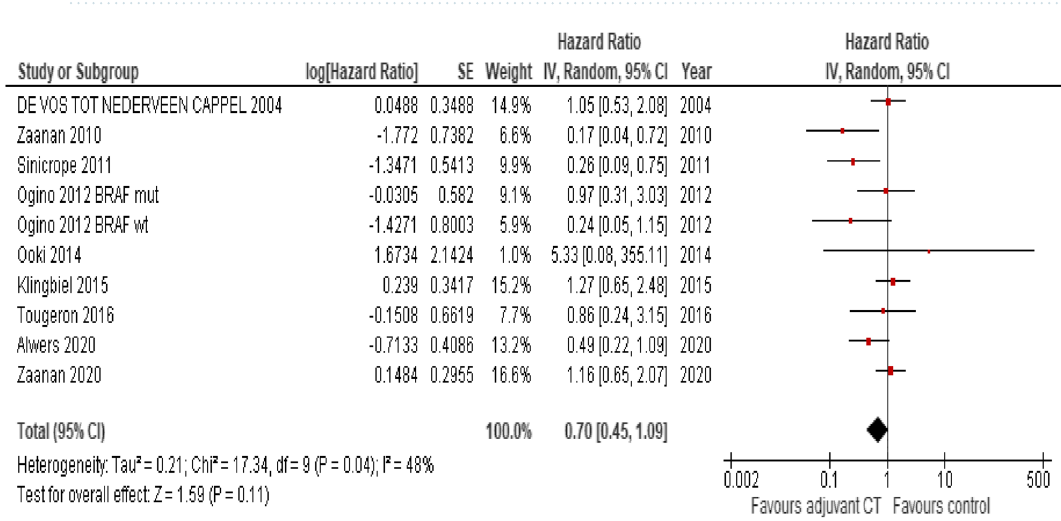
Figure 2. Forest plot for overall survival in MSI-H treated with adjuvant chemotherapy (polychemotherapy or single agent) vs control arms (single agent or surgery alone).